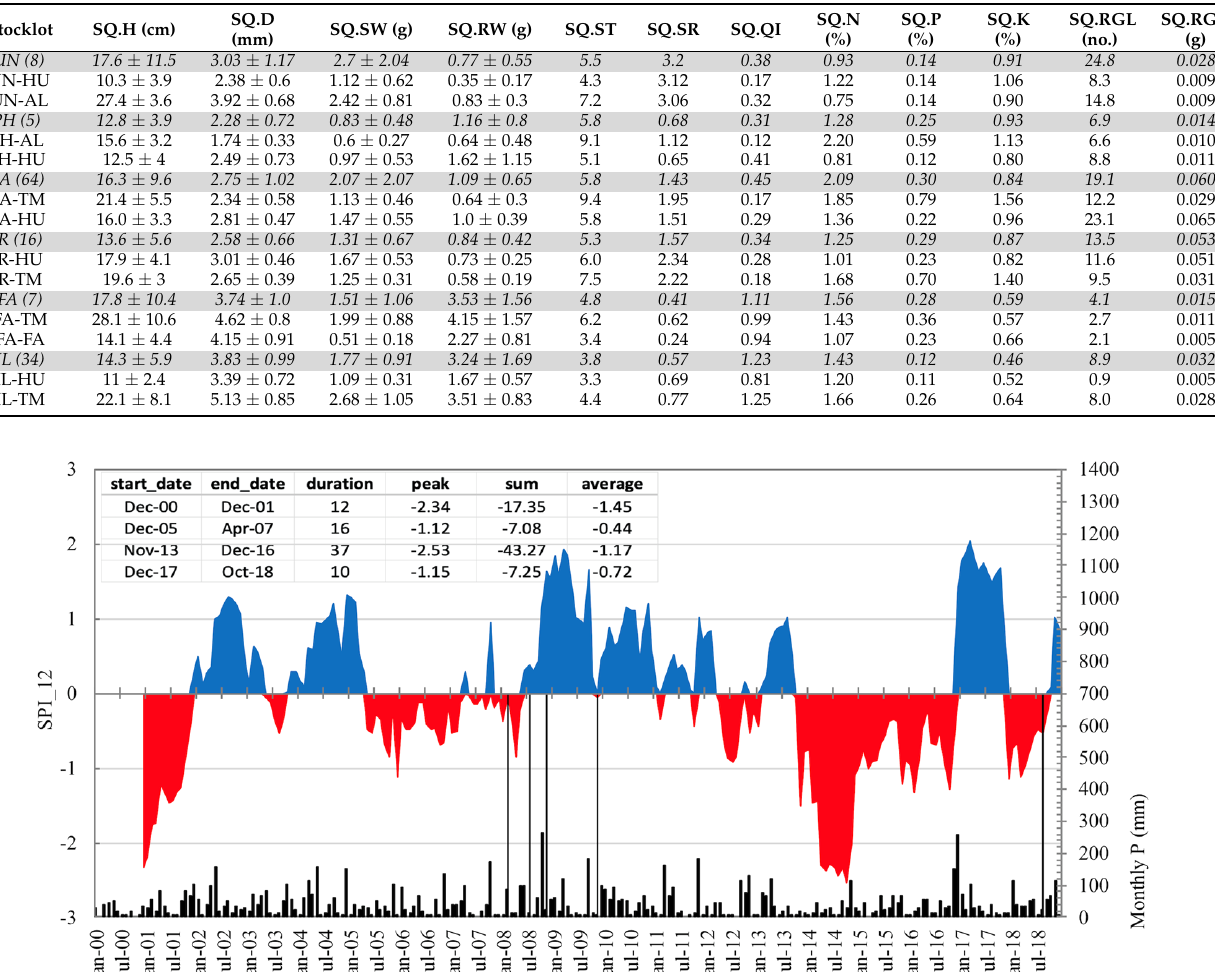
Table 3. Mean values and standard deviation (omitted in some variables for simplicity) for the mor- phological, physiological, and performance seedling quality attributes measured on the 12 stocklots of the six participating species (between December 2007 and January 2008). Shaded area and italic font correspond to the values established for the target seedling obtained from several years of im- provement across the region of Valencia. For Lusitanian oak (QUFA), this standard is not established, and the values correspond to the historical average of surveyed stocklots produced and planted since 2002. The number of stocklots out of which the average is computed is presented in parentheses besides the species’ code. Abbreviations are presented in Tables 1 and 2.